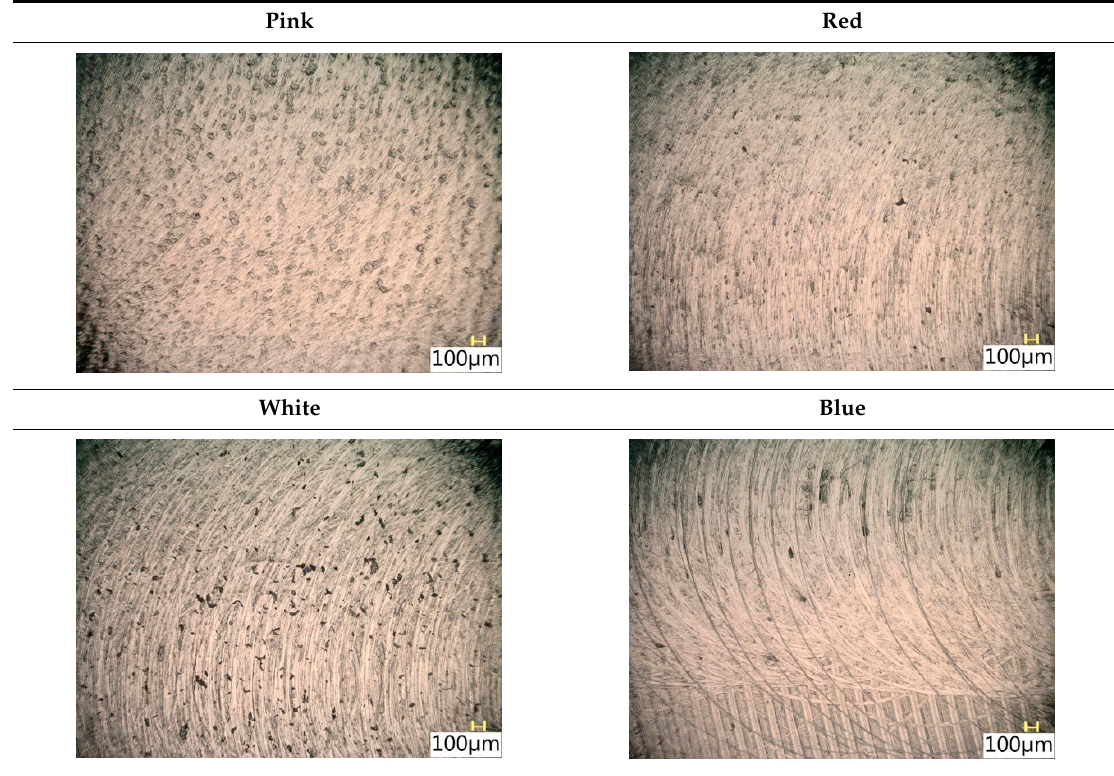
Table 6. Surface texture after brushing with the “high” spring in the offset adjustment sleeve.